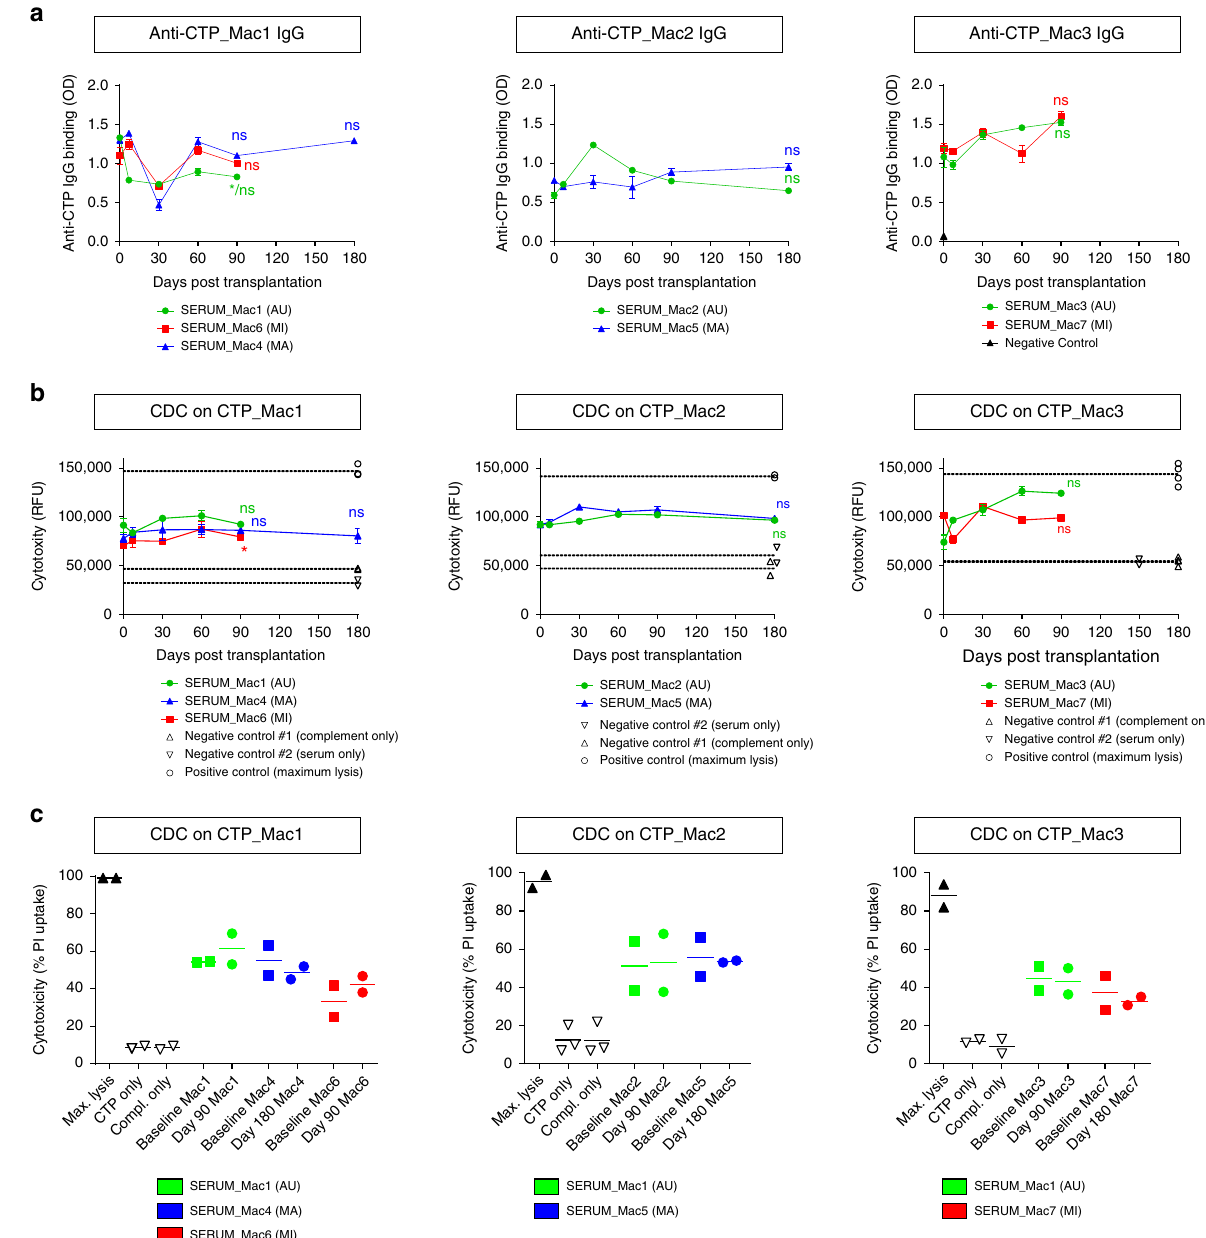
Fig. 7 Detection of hemolytic CTP-speci fi c antibodies in the serum of transplanted macaques. The sera of AU, MA, MI recipients were collected before and at different time-points following transplantation. a The presence of anti-CTP IgG was detected by cell-based ELISA. b The capability of anti-graft antibodies to trigger the complement-dependent cytotoxicity was also evaluated by measuring the fl uorescence signal of the Cell-Tox Green probe (for ( a ) and ( b ) data are expressed as mean ± s.e.m of n = 3 replicates, one-way ANOVA followed by Dunnett ’ s multiple comparisons post hoc test using day 0 as control; for b positive and negative controls: individual replicates shown) or c by measuring the percentage of the dead cells (propidium iodide-positive cells) by fl ow cytometry ( n = 2 technical replicate of single biological samples, mean per time point) From the genotypes obtained for the 17 microsatellites, the most probable and placed in the magnet in a sphinx position with the head fi xed in a stereotactic haplotypes were deduced for each animal 14 . As reported previously, seven MRI-compatible frame (M2E, France). NHPs were heated by a hot air fl ux and their temperature and respiration parameters monitored remotely. founder MHC haplotypes (M1 to M7) were identi fi ed in the Mauritian macaque All acquisitions were performed on a horizontal 7 T Varian scanner (Palo Alto, population as well as recombinant haplotypes derived from these seven CA, USA) equipped with a gradient coil reaching 100 mTm − 1 (300 μs rise time). A haplotypes 14,23 . The genotypes of the animals are shown in Supplementary Fig. 1 and Table 1. surface coil (RAPID Biomedical GmbH, Rimpar, Germany) was used for transmission and reception. T2-weighted images were acquired using a high- resolution 2D fast spin-echo sequence (469× 469μm² in-plane resolution, 1 mm Imaging in NHPs . Magnetic resonance imaging (MRI) was performed on all NHPs slice thickness, 70 slices), with echo time TE/ Repetition time TR = 20/8000 ms, 5 echoes, effective TE = 52.5 ms and acquisition time Tacq = 43 min. For T2*- at baseline in order to determine the stereotactic coordinates for surgery and was weighted images the parameters used were: 469× 469 μm² in-plane resolution, repeated monthly to monitor grafts. 1 mm slice thickness, 40 slices, 5 TE (from 5.5 to 30 ms), repetition time TR = 2 ms Primates were induced with ketamine (1mgkg − 1 ) and xylazine (0.5mgkg − 1 ), and acquisition time Tacq = 8min. maintained anesthetized with an intravenous (i.v.) infusion of propofol(1mlkg − 1 h − 1 ) NATURE COMMUNICATIONS| (2019) 10:4357